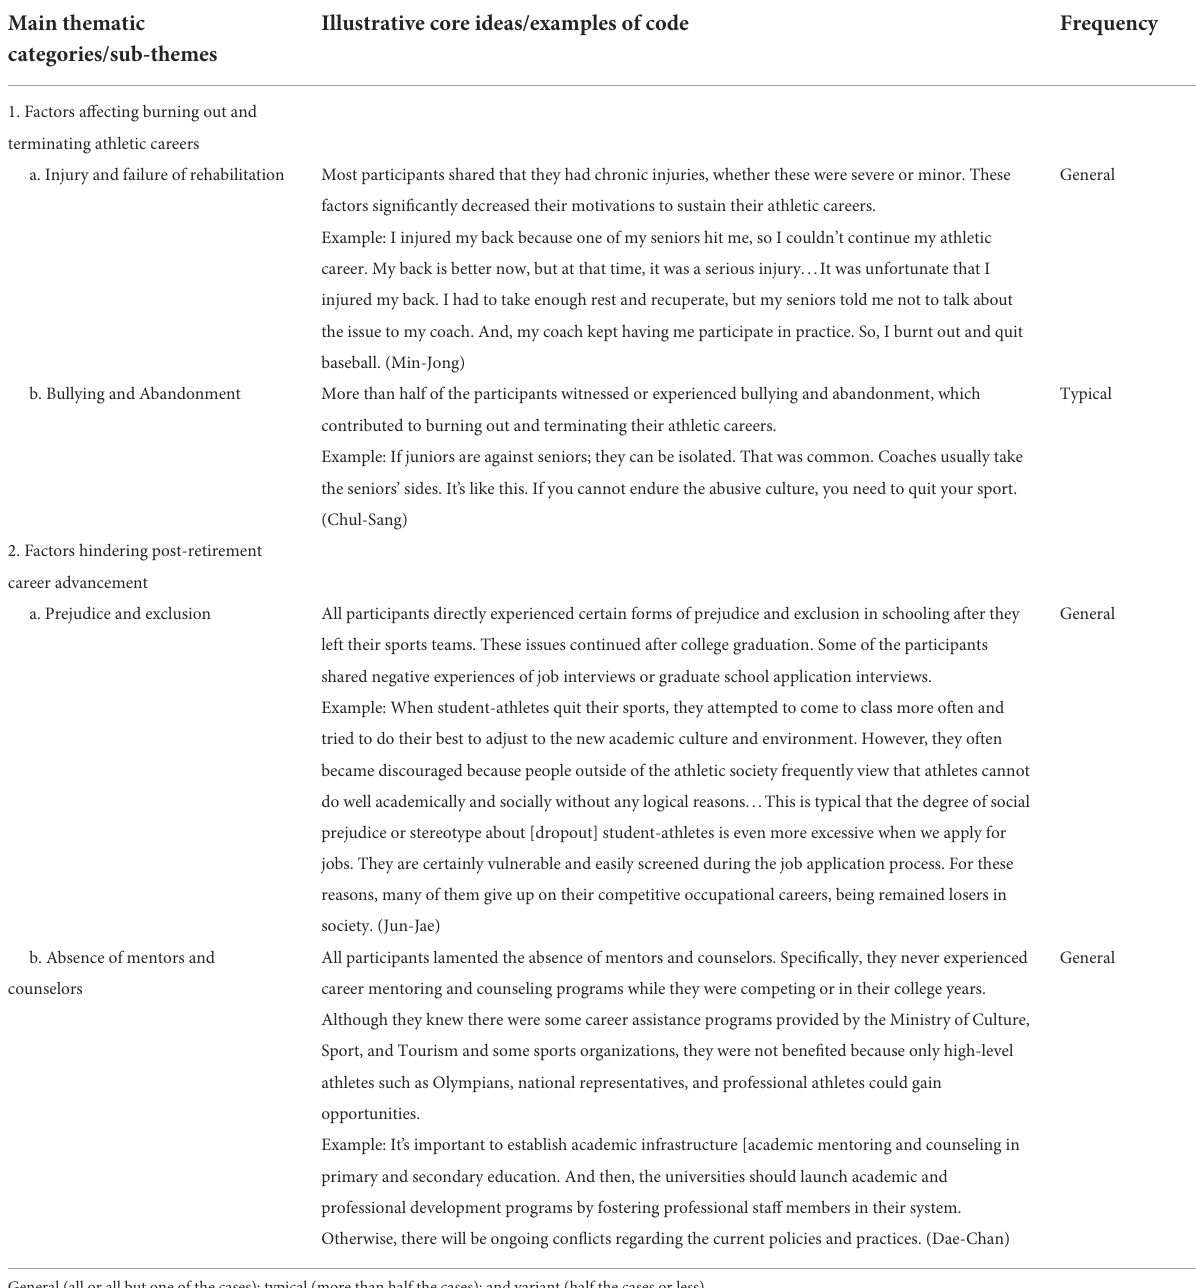
TABLE 3 Summary of main and sub-themes, illustrative core ideas, and examples of